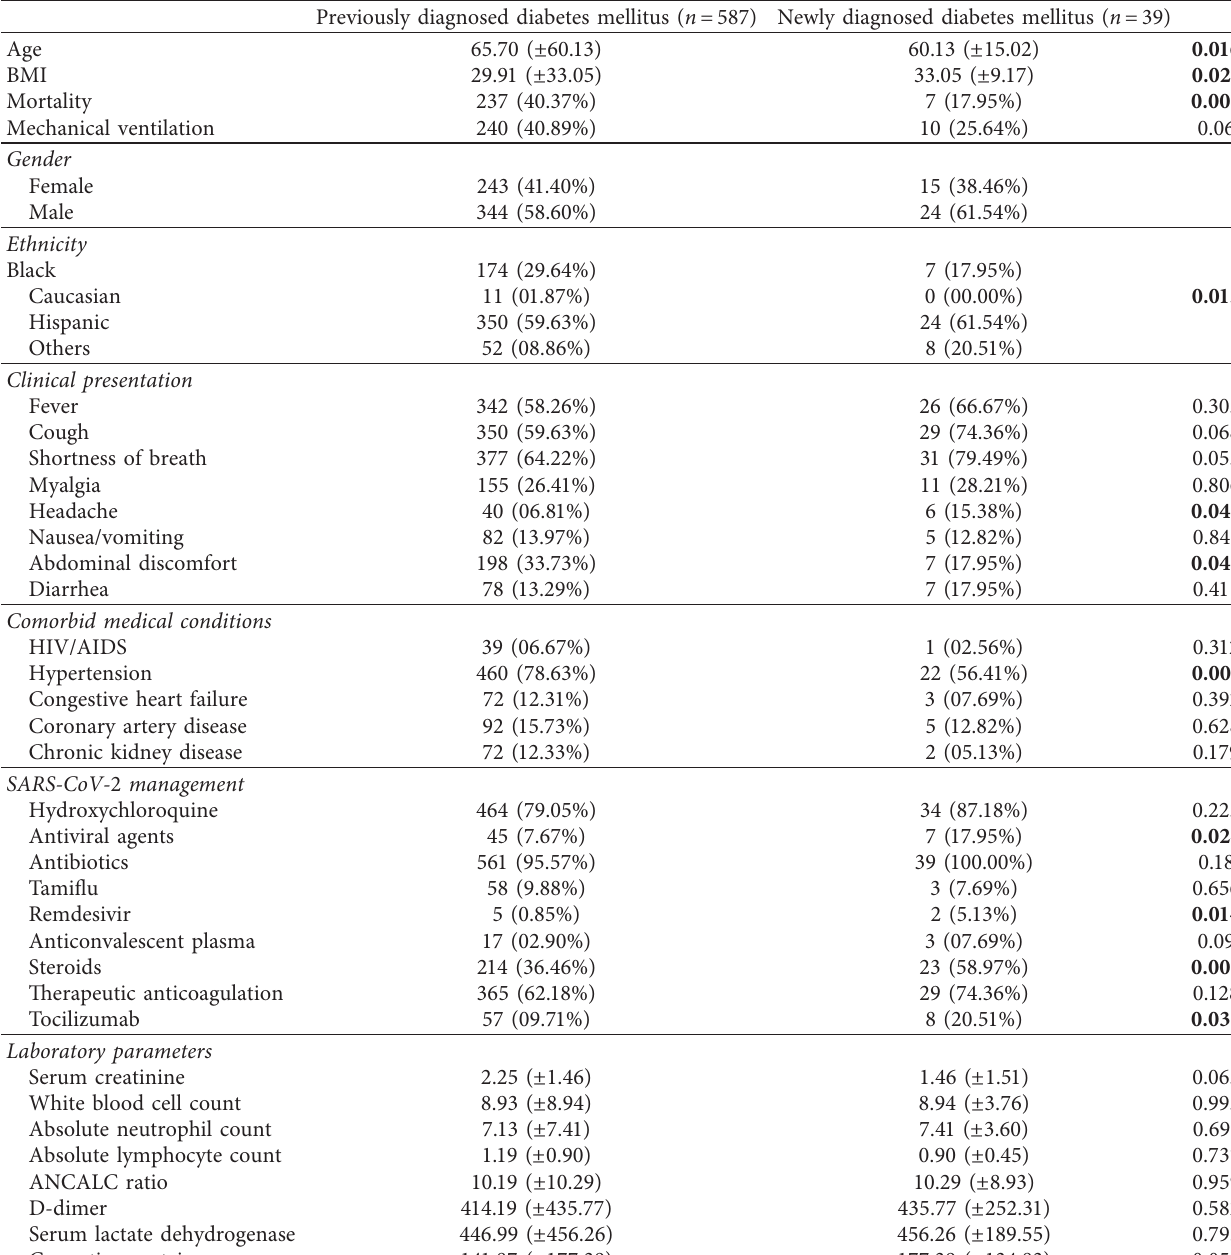
Table 6: Comparison of demographic, clinical, and laboratory variables among the previously and newly diagnosed type-2 diabetes